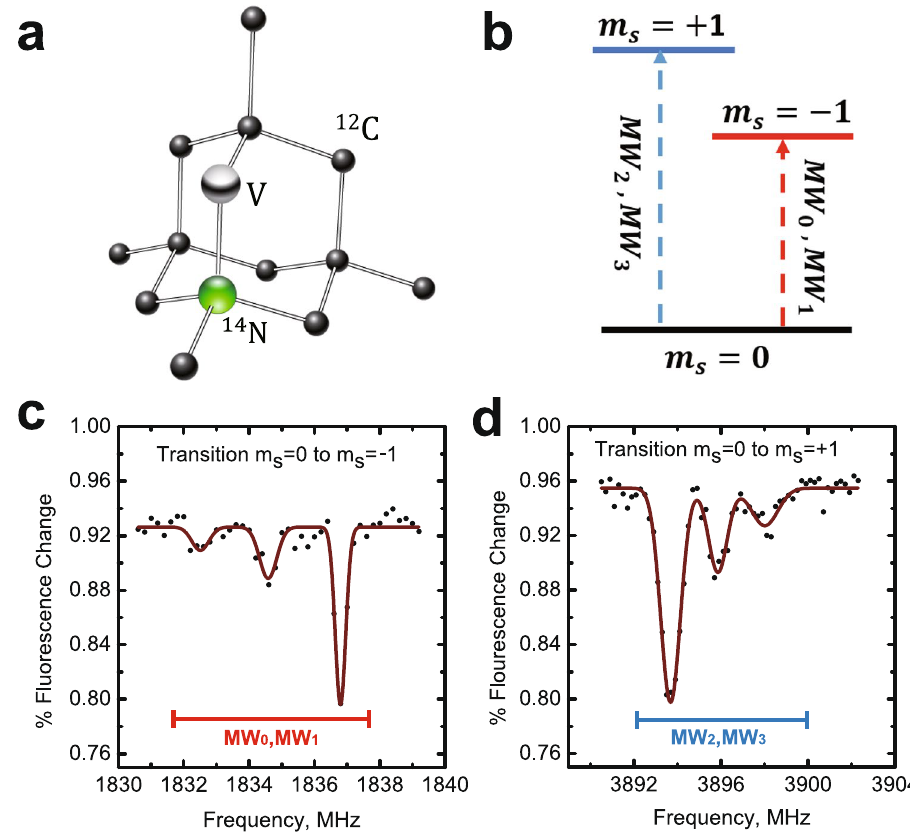
Figure 1. Typical structure of NV center in pure diamond single crystal. ( a ) The NV center consists of a nearest-neighbor pair of a 14 N atom, which substitutes for a 12 C atom, and a lattice vacancy (V). ( b ) Three energy levels of the ground state of NV center. The electron spin state is controlled by MW pulses. MW 0 and MW 2 indicate MW pulses with a phase of 0, while MW 1 and MW 3 indicate MW pulses with a phase of π /2. ( c ) ODMR spectra of transition m